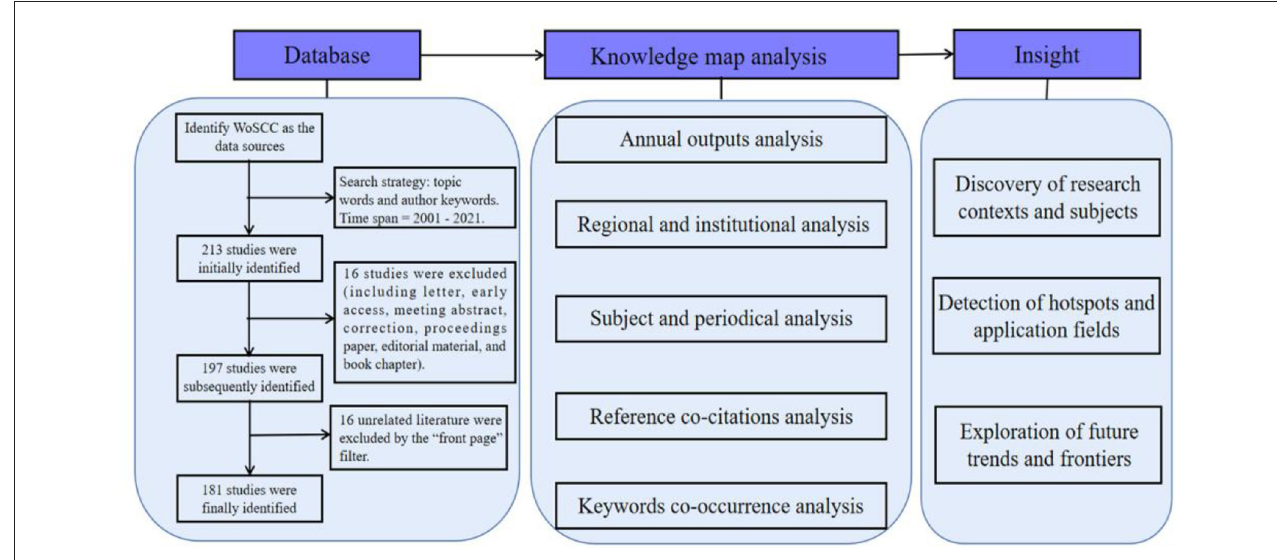
FIGURE 1 | The summary of the flowchart and study